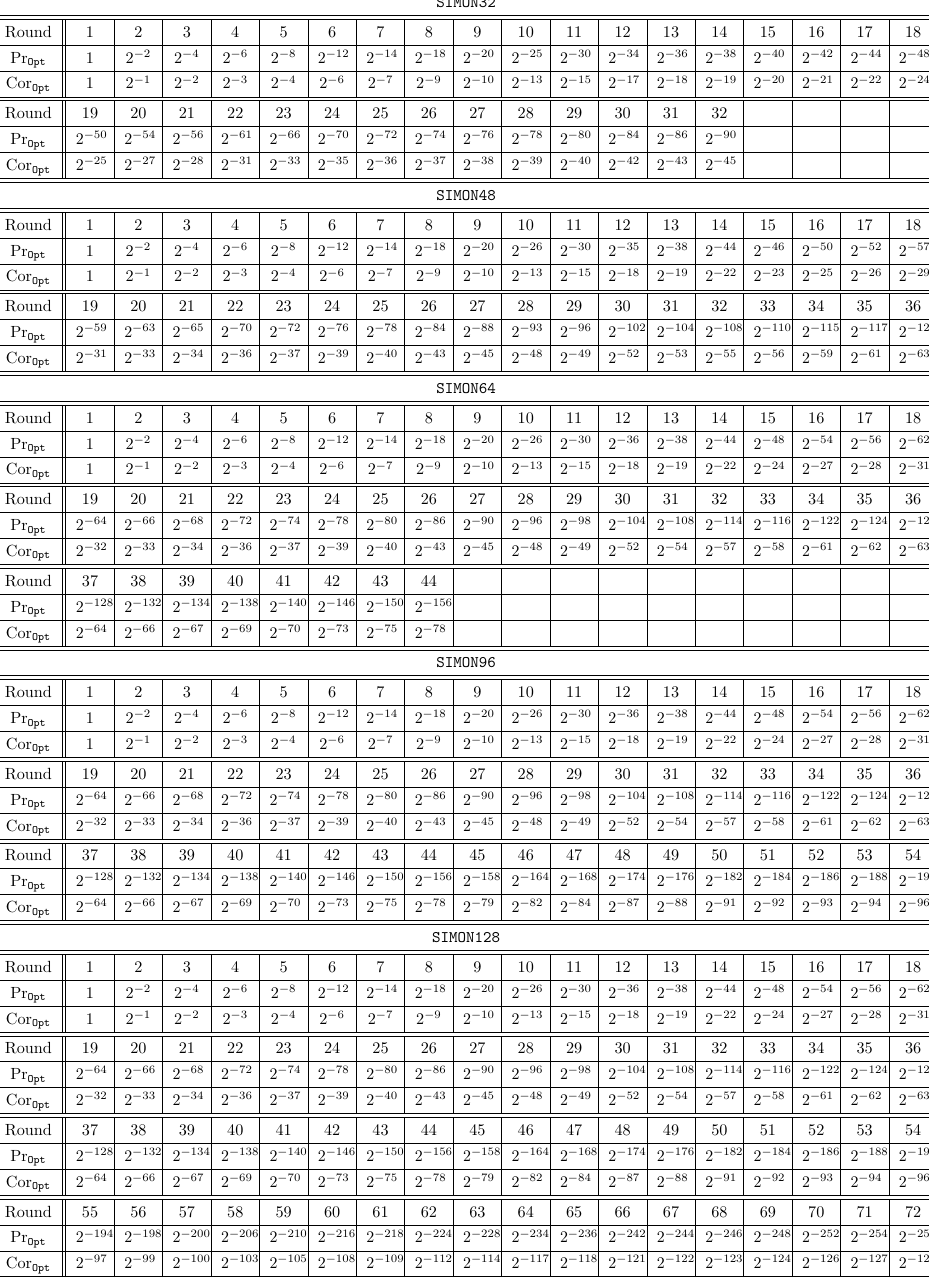
Table 9: Experimental results of SIMON Family of Block Ciphers.